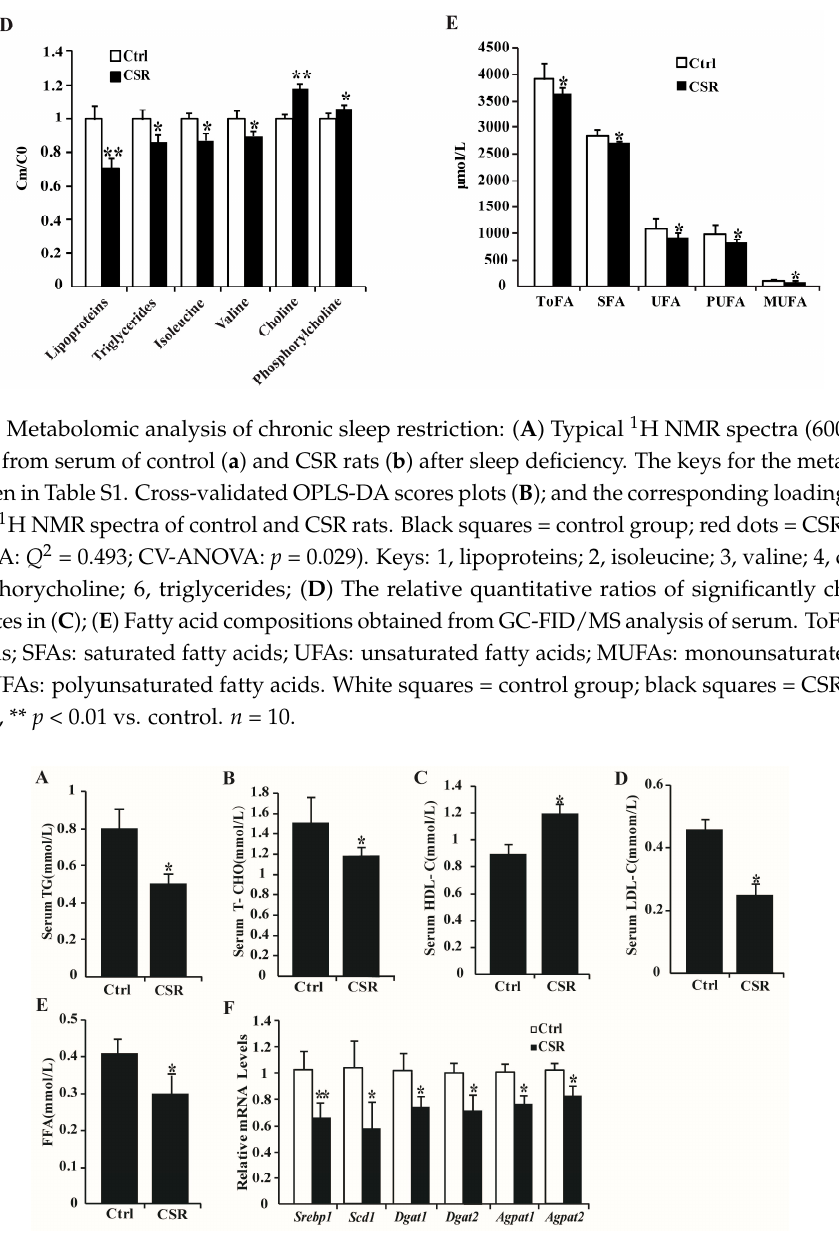
Figure 4. Chronic sleep restriction decreased serum lipid metabolic parameters and expression of lipid metabolic genes in the liver: Serum concentration of: Tg ( A ); T-CHO ( B ); HDL-C ( C ); LDL-C ( D ); and FFAs ( E ) were measured after CSR. ( F ) Relative mRNA levels of lipid metabolic genes in the liver of control and CSR rats. White squares = control group; black squares = CSR group. * p < 0.05, ** p < 0.01 vs. control. n = 5.